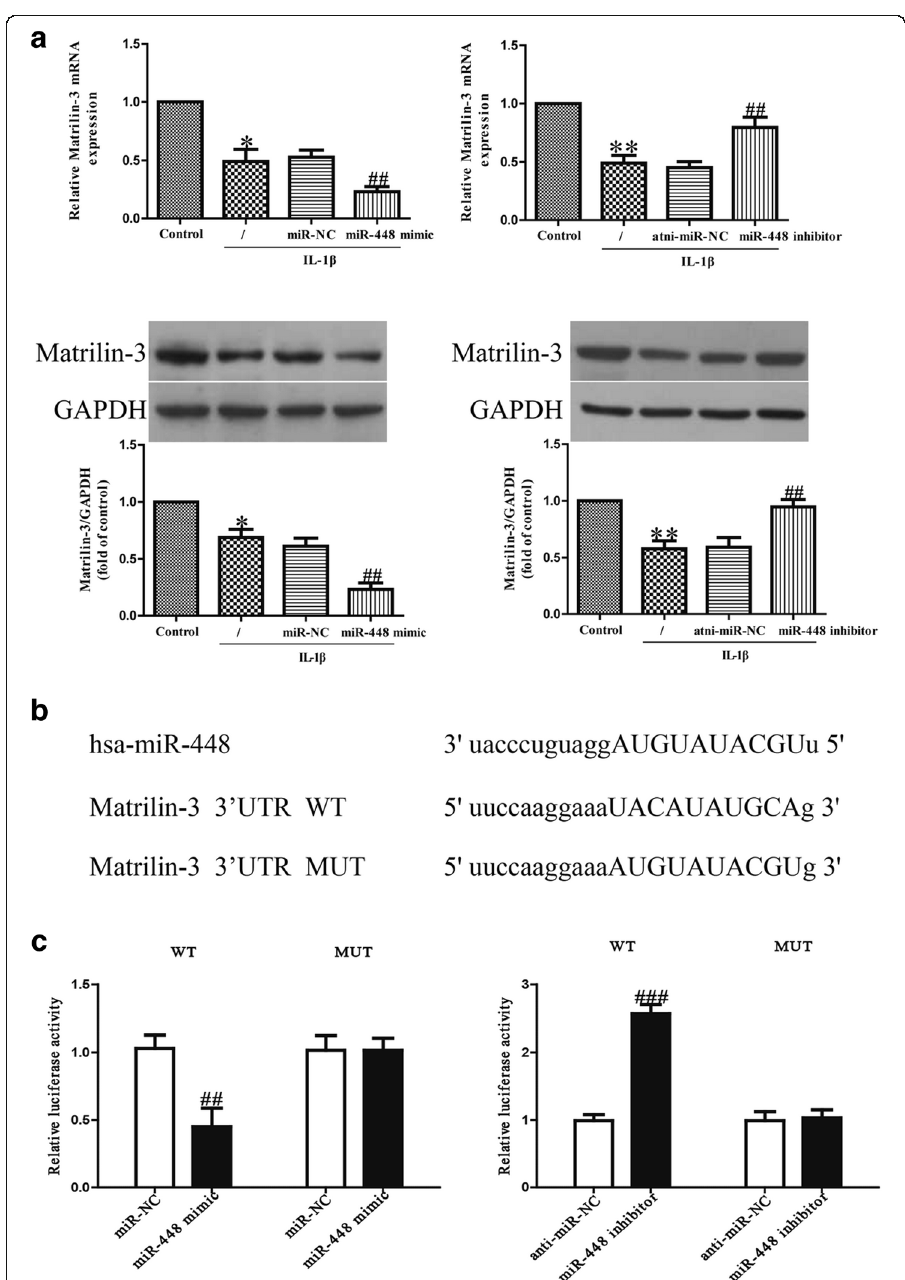
Fig. 4 Matrilin-3 was a direct target of miR-448. Chondrocytes were treated with 5 ng/ml IL-1 β for 24 h after transfection with miR-448 mimic or inhibitor. a The mRNA and protein levels of matrilin-3 were respectively determined using quantitative real-time PCR and western blot. Matrilin-3 expression was normalized to GAPDH. b Schematic representation of matrilin-3 3 ’ UTRs showing putative miRNA target site. c The analysis of the relative luciferase activities of matrilin-3-WT and matrilin-3-MUT. All data are presented as means ± SEM, n = 4. * p < 0.05, ** p < 0.01 vs. control; ## p < 0.01, ### p < 0.001 vs. vehicle + IL-1 β or miR-NC or